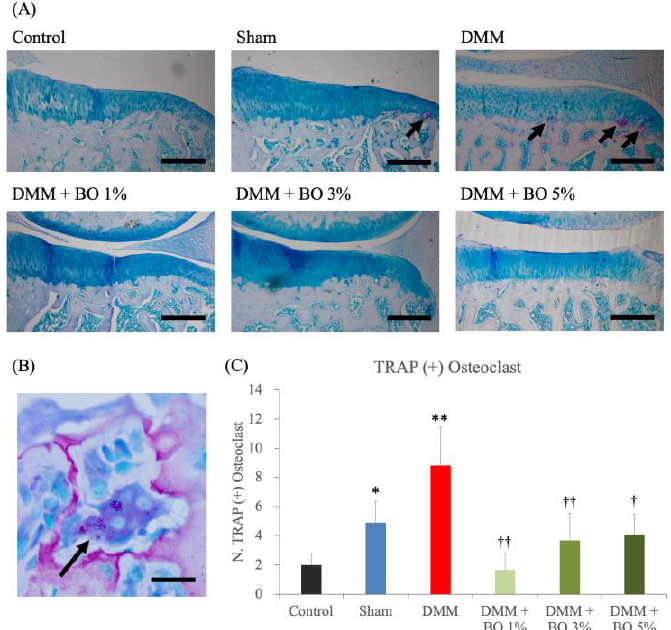
Figure 4. Histological analysis for the number of TRAP-positive osteoclasts. ( A ) Representative pictures of TRAP staining for the right knees. Magnification: × 40. Scale bars = 200 µ m. ( B ) Multinucleated TRAP-positive osteoclast (arrows). Magnification: × 1000. Scale bars = 10 µ m. ( C ) The number of TRAP positive osteoclasts in the subchondral bone in the right knee. * p < 0.05, ** p < 0.01 vs. Control, † p < 0.05, †† p < 0.01 vs. DMM by Tukey–Kramer test. BO; Boiogito, DMM; Destabilization of the medial meniscus, TRAP; Tartrate-resistant acid phosphatase.